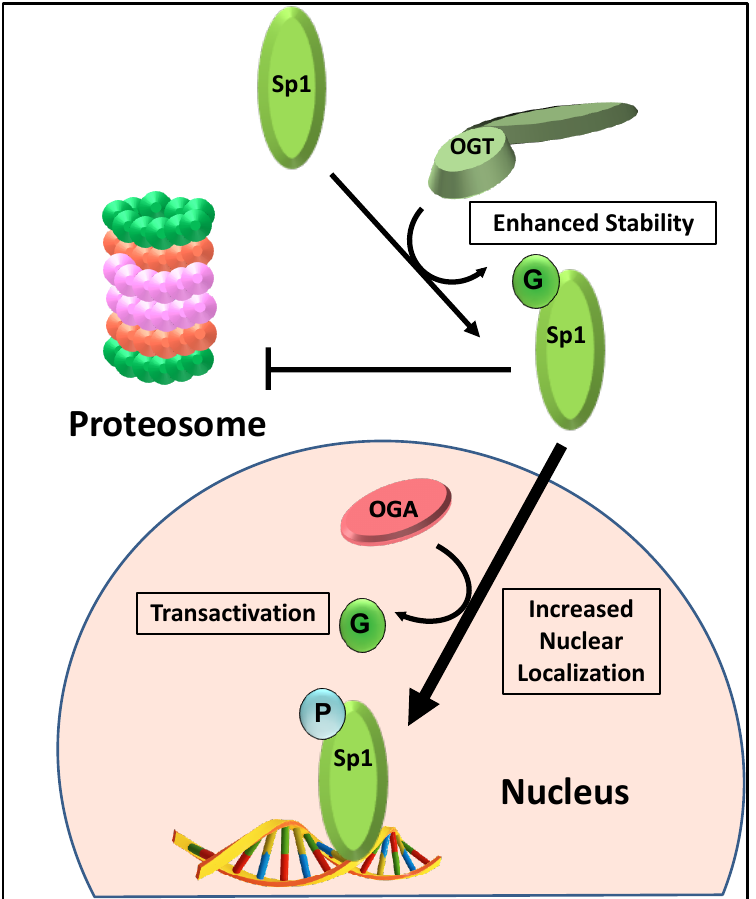
Figure 5. O-GlcNAcylation regulates the stability, nuclear localization, and transactivation of Sp1. Sp1 is a transcription factor that serves as a prototype of how transcription factors are regulated by O-GlcNAcylation at multiple levels. The O-GlcNAcylation of Sp1 (green circle “G”) prevents proteasomal degradation and promotes nuclear localization (large arrow). Once in the nucleus, OGA must remove O-GlcNAc from Sp1 so that it can be phosphorylated to facilitate binding to